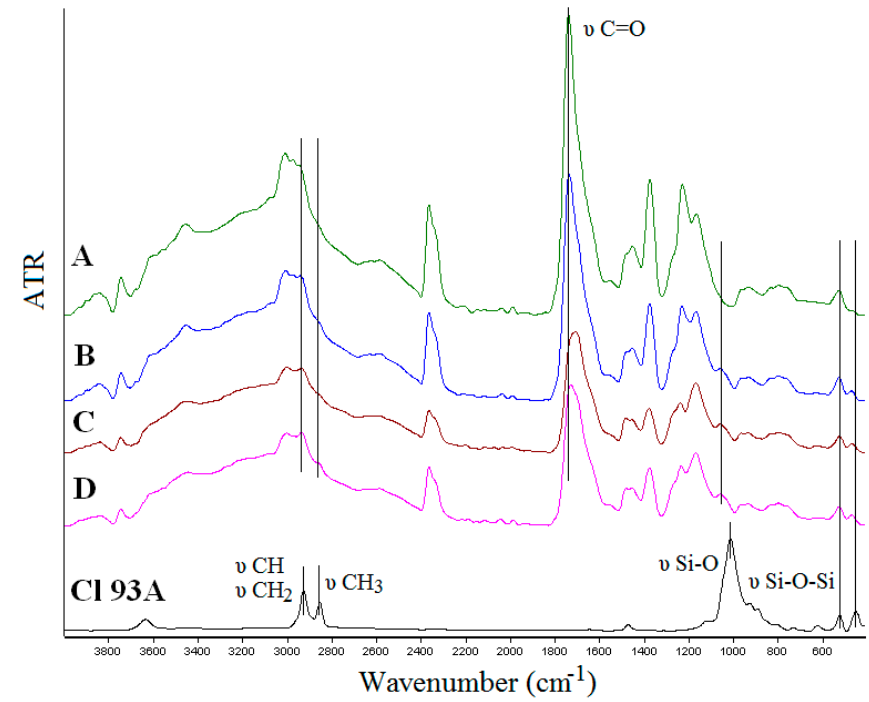
Figure 3. FTIR spectra of nanocomposite hydrogels: A-PMAA; B-PMAA-Cl 93A; C-PMAA-Cl 93A-C8; D-PMAA-Cl 93A-C18 and commercial clay-Cl 93A.